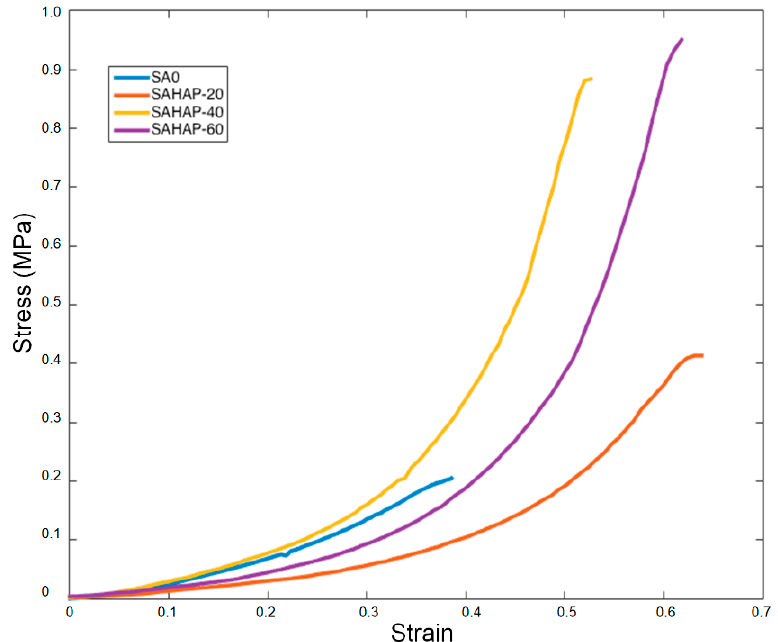
Figure 7. Stress–strain relationships for distinct HA integration within the SA hydrogels.